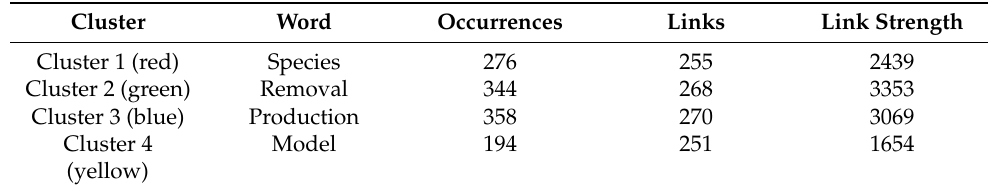
Table 2. The topmost occurring terms from the four respective clusters of Figure 3a. Cluster Word Occurrences Links Link Strength Cluster 1 (red) Species 276 255 2439 Cluster 2 (green) Removal 344 268 3353 Cluster 3 (blue) Production 358 270 3069 Cluster 4 Model 194 251 (yellow)